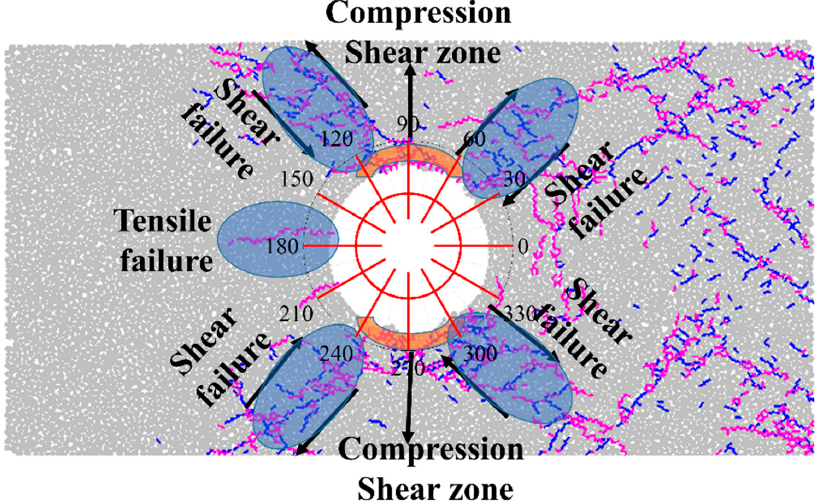
Figure 22. Failure mode of different areas around the hole.